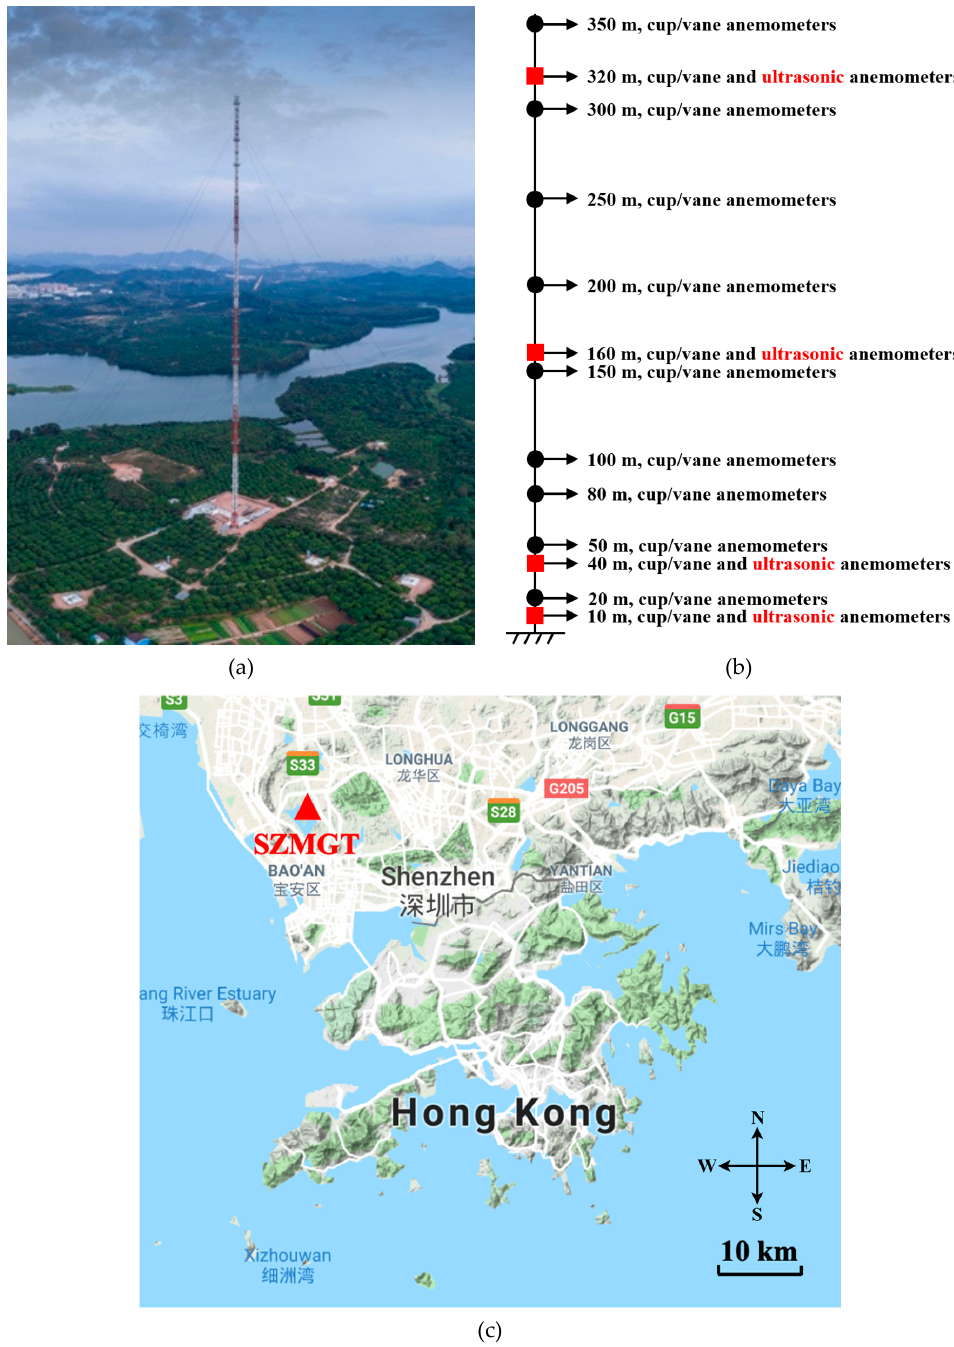
Figure 1. ( a ) Bird view of Shenzhen Meteorological Gradient Tower (SZMGT), ( b ) locations of anemometer installation, and ( c ) the geographical location of SZMGT (red triangle) in Google